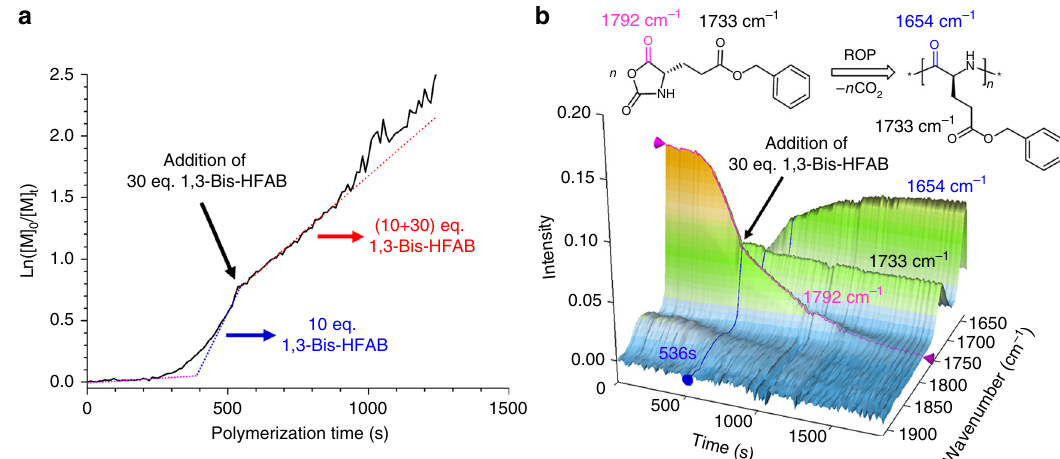
Fig. 6 In situ FT-IR monitoring of polymerization. a plot of Ln([M] 0 /([M] t ) vs. polymerization time (conditions: [Glu-NCA] 0 = 0.19 M, [Glu-NCA] 0 /[1,3- Bis-HFAB] 0 /[DMEA] 0 = 120/(10 + 30)/1, 25 °C, CH 2 Cl 2 ); b corresponding 3D kinetic behavior pro fi le from in situ FT-IR (Source data are provided as a Source Data fi in 9 h. The resultant polymer showed a bimodal SEC trace (with a shoulder peak) and a higher molecular weight (M n,SEC- = 6.10 × 10 4 ) than the theoretical molecular weight (M n,calcd = 3.58 × 10 4 ). Also, the monomer could not be completely converted to polypeptides even with a very long reaction time (1 day).